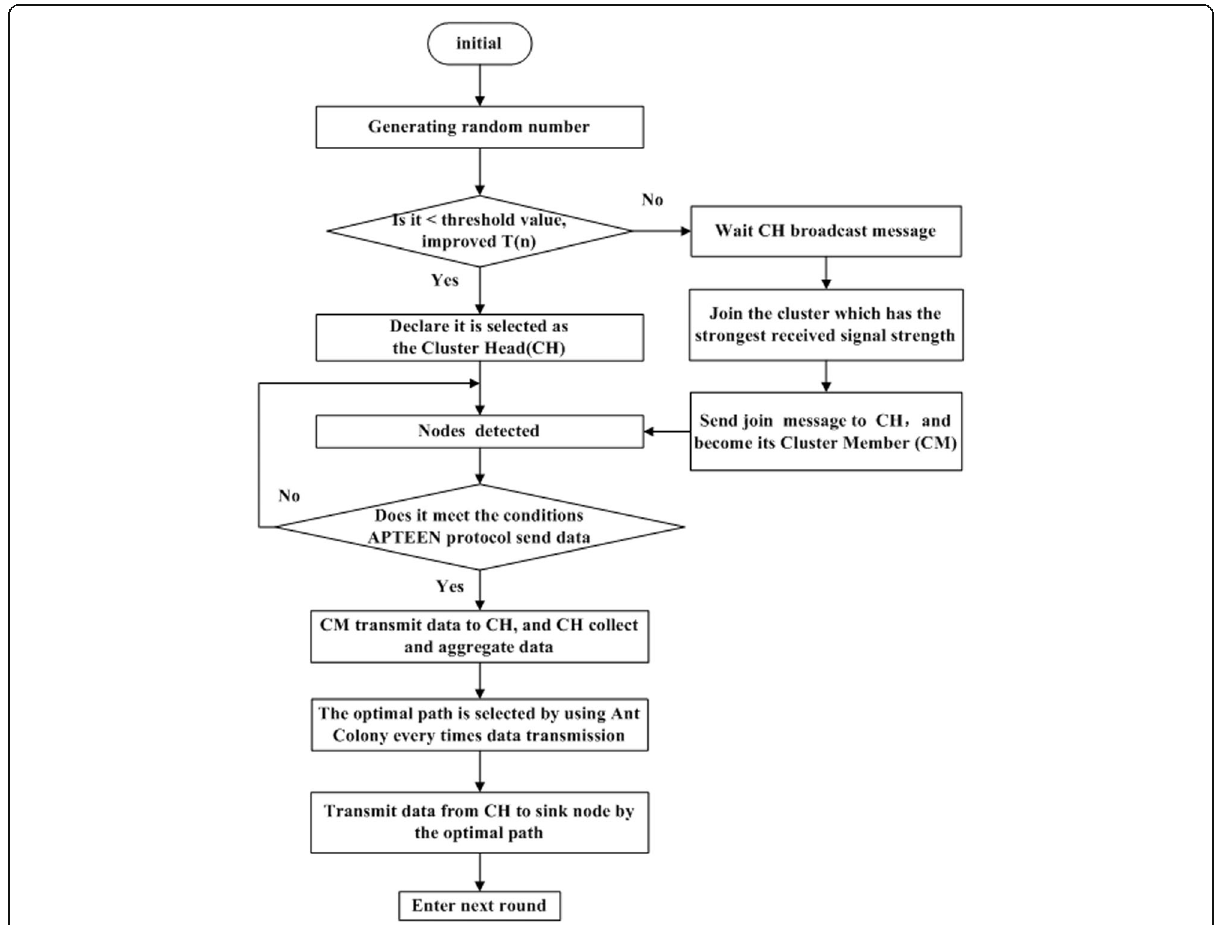
Fig. 5 Flow of the AMAPTEEN protocol. The generated random number is compared with the formula threshold to determine CH. The non-CH node selects the CH with the strongest received signal to join and become the cluster ’ s CM. Nodes are divided dynamically into several clusters. A virtual link between the CH and the CMs is established. CH selects the CM node with the largest pheromone concentration on the link as IM_node. The IM_node is chosen by CH whenever there are data transmitted from CH to sink node. CM sends the sensed data to CH in its allocated TDMA slot. When CH receives the data from all the CMs, it collects and aggregates data and sends the merging message to IM_node. The IM_node forwards the message to far sink node. The choice of IM_node depends on node maximal pheromone concentration, and thus, choosing the data transmission path is relatively optimal. And it is likely to be different, so there will be formed multiple data transfer paths from CH to